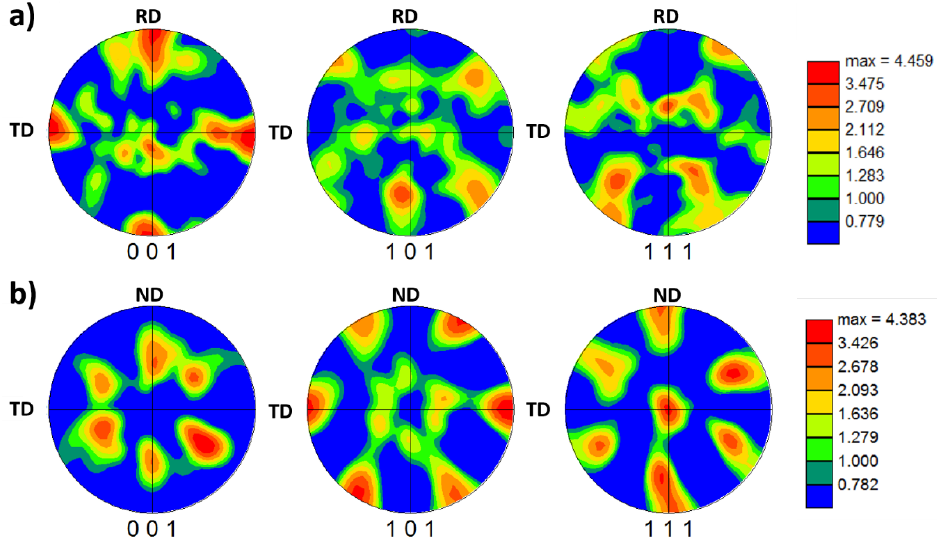
Figure 18. Pole figures (001, 101, and 111) obtained from the OIM data given in Figure 18 for the AA5052-H32 BM ( a ) and for the SZ after FSSW ( b ).